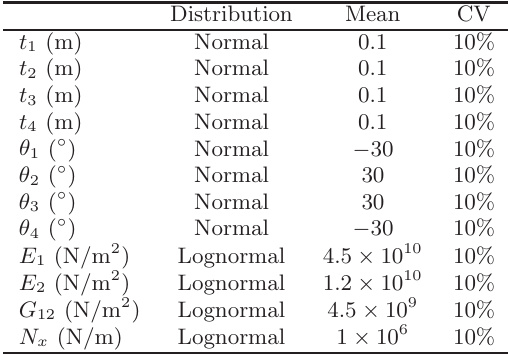
Table 6. Statistical parameters of design variables of the laminated composite plate, case 2.